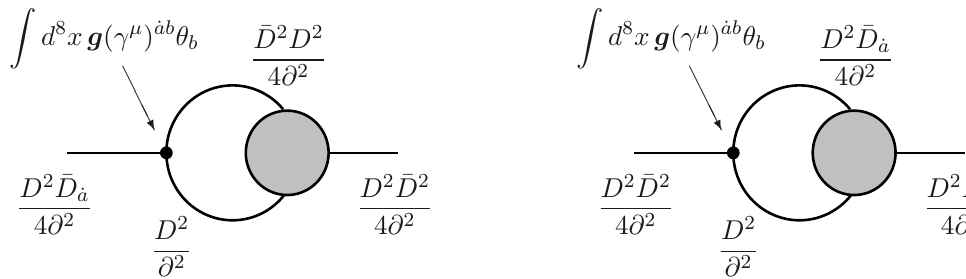
Figure 3 . This figure illustrates how singularities can appear in the case of the existence of coinciding momenta. In the left diagram the external momentum is q µ , while in the right one the external momentum is − ( q + k ) µ . This implies that they can give terms proportional to q µ /q 4 and ( q + k ) µ / ( q + k ) 4 , respectively.